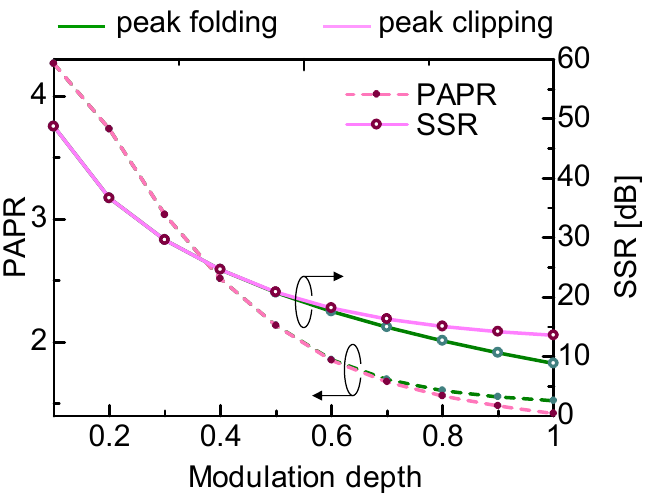
Figure 7. PAPR and SSR of peak clipped OSSB-SC signal.